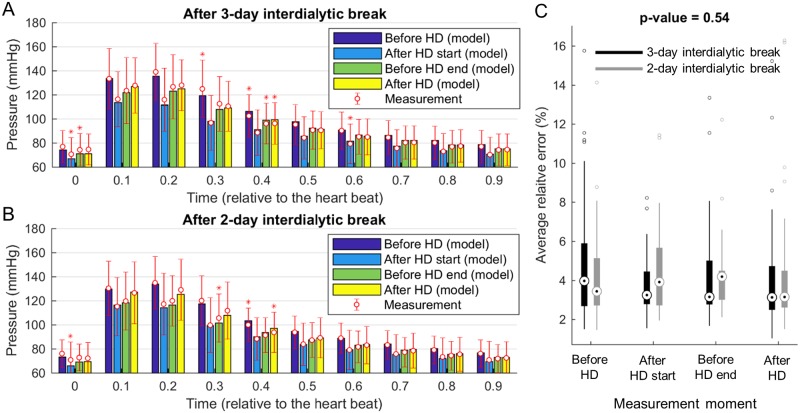
Comparison of the model predicted and measured pressure profiles in radial artery.Bars represent average model-predicted pressures at different measurement moments after 3- (A) and 2-day (B) interdialytic break. Shown are also inter-patient means and standard deviations for measurements (circles with whiskers) whereas standard deviation from the model is omitted for clarity. Asterisks indicate statistical difference at p-value < 0.05 calculated using paired sample t-Test. (C) Quality of the model approximation, i.e. average relative error between simulated and recorded radial pressure waveform, does not depend on the measurement moment.